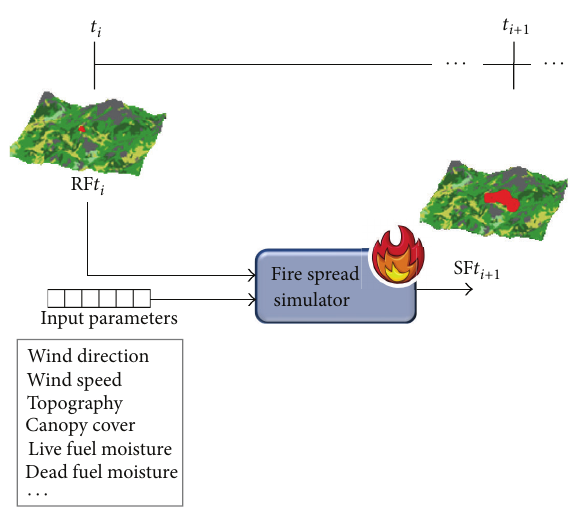
Figure 1: Classical prediction schema. RF and SF stand for real fire and simulated fire ,